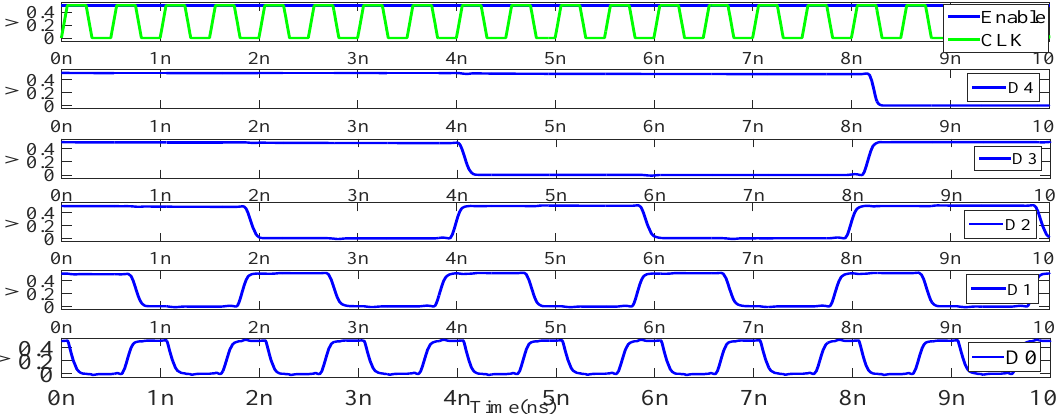
Figure 15. Output waveform of the 8-bit counter.